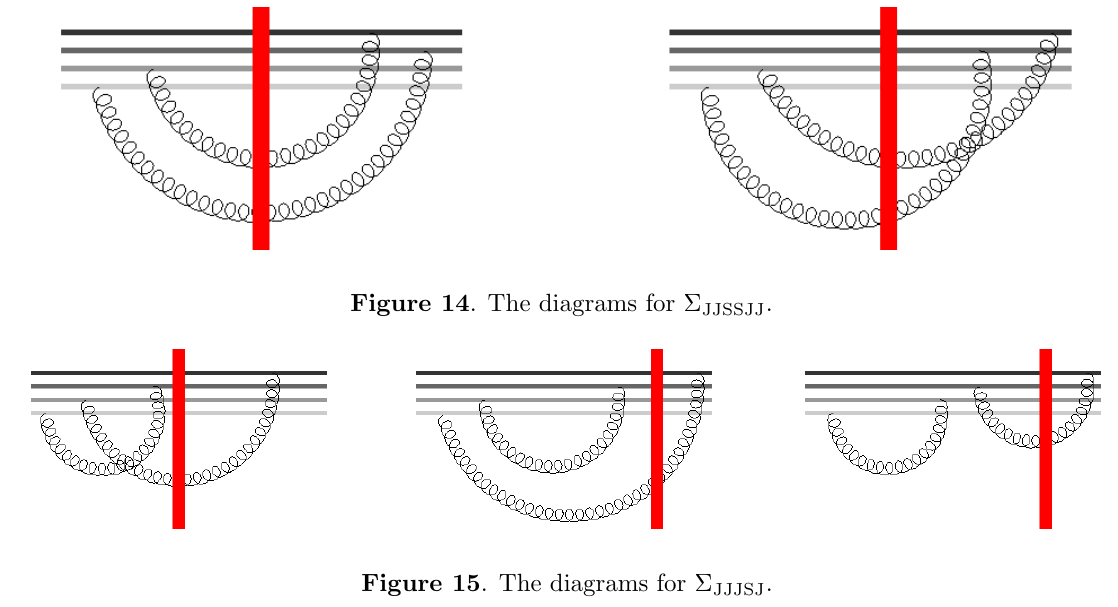
Figure 15 . The diagrams for (cid:6) JJJSJ